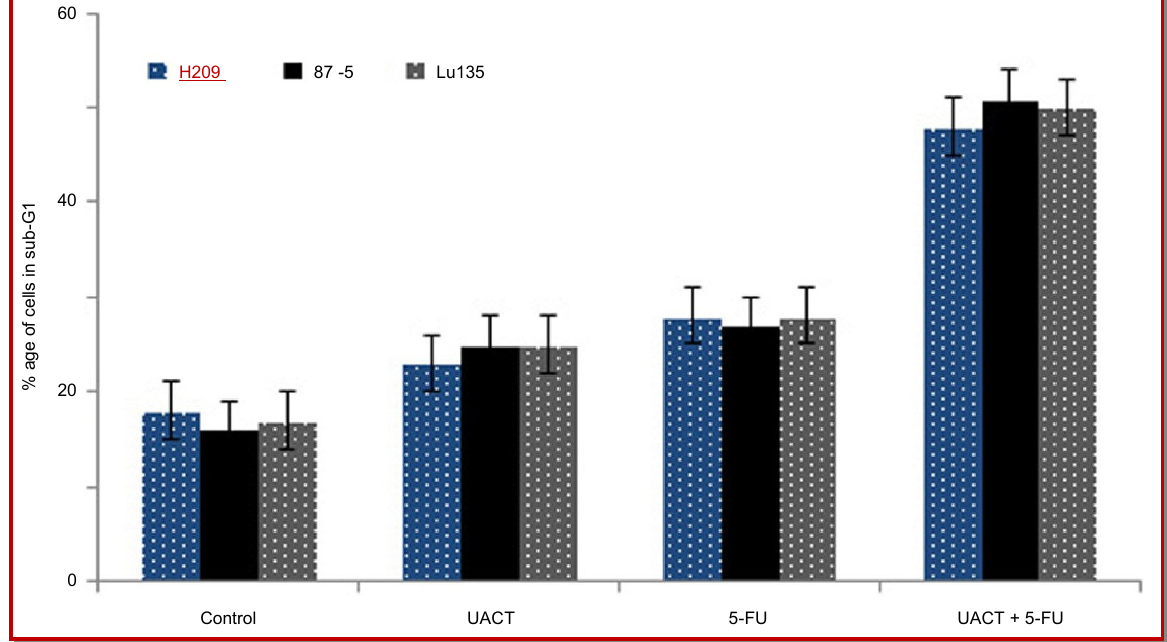
Figure 6: Effect of the sequential treatment with UACT and 5-FU combination on H69, 87-5 and Lu135 SCLC cell lines H69, 87-5 and Lu135 cells were treated with sequential combination of UACT for 24 hours followed by 5-FU for 24